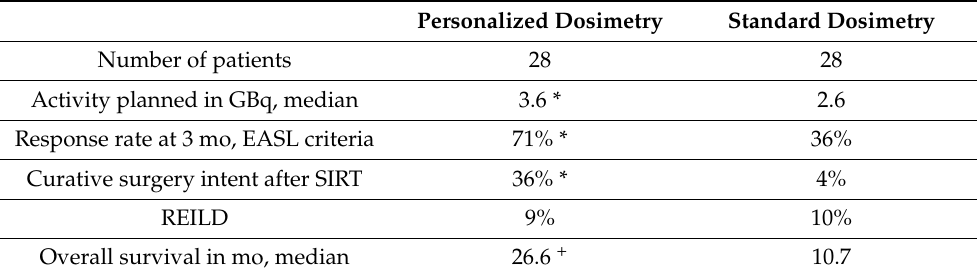
Table 5. Main results of the DOSISPHERE-01 randomized controlled trial